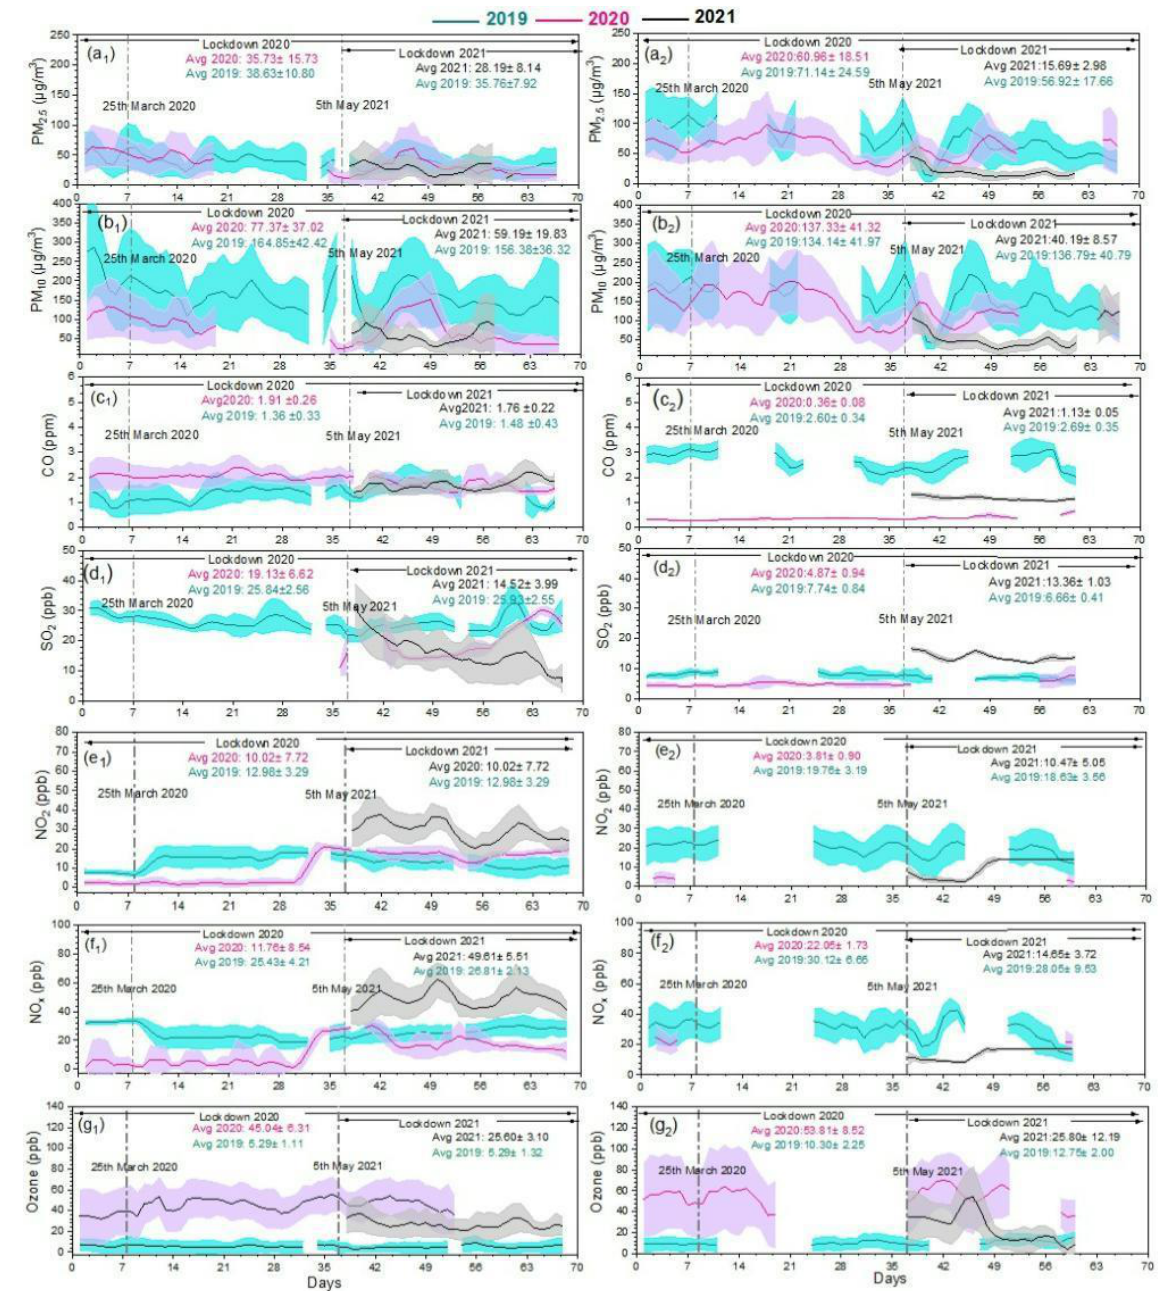
Figure 3. Temporal variation in pollutants PM 2.5 , PM 10 , CO, SO 2, NO 2 , NO x , and O 3 during LD2020 and LD2021 at site #1 ( a 1 – g 1 ) and site #2 ( a 2 – g 2 ) (dotted vertical line shows the start of LD2020 and LD2021).